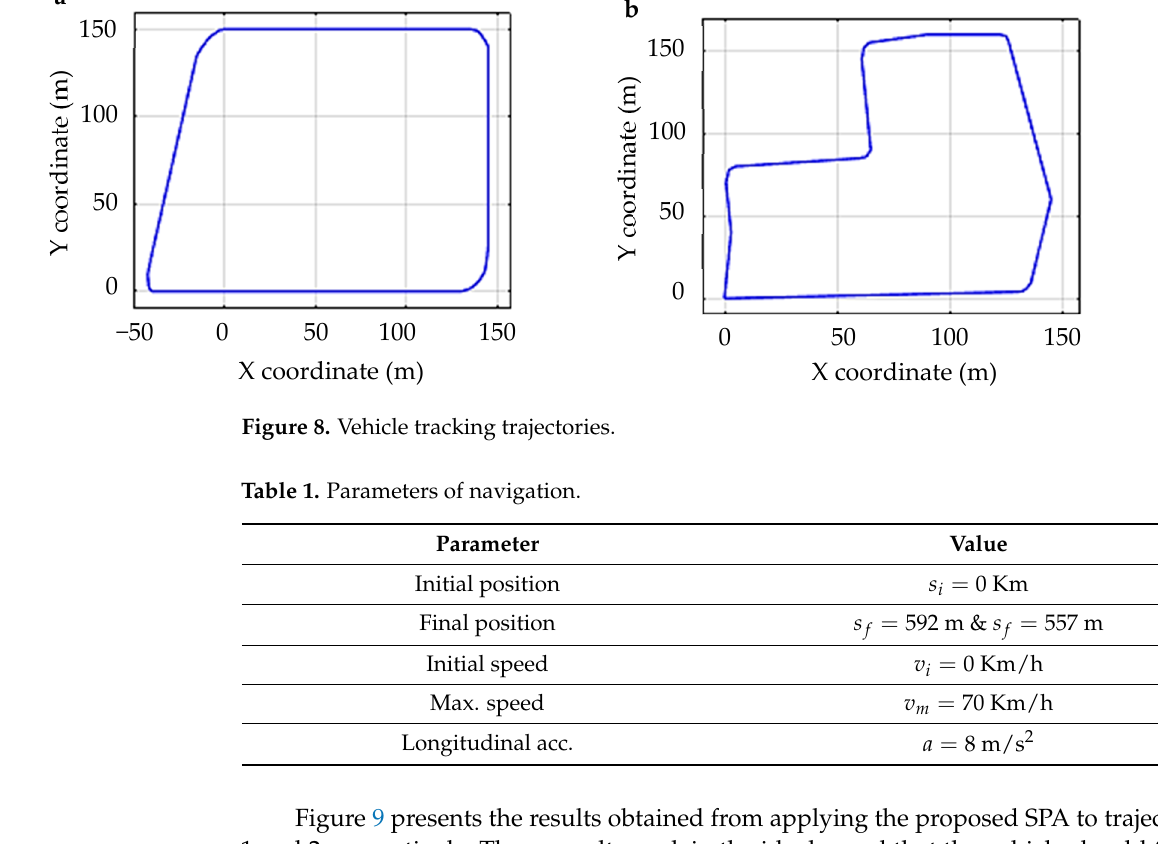
Table 1. Parameters of navigation